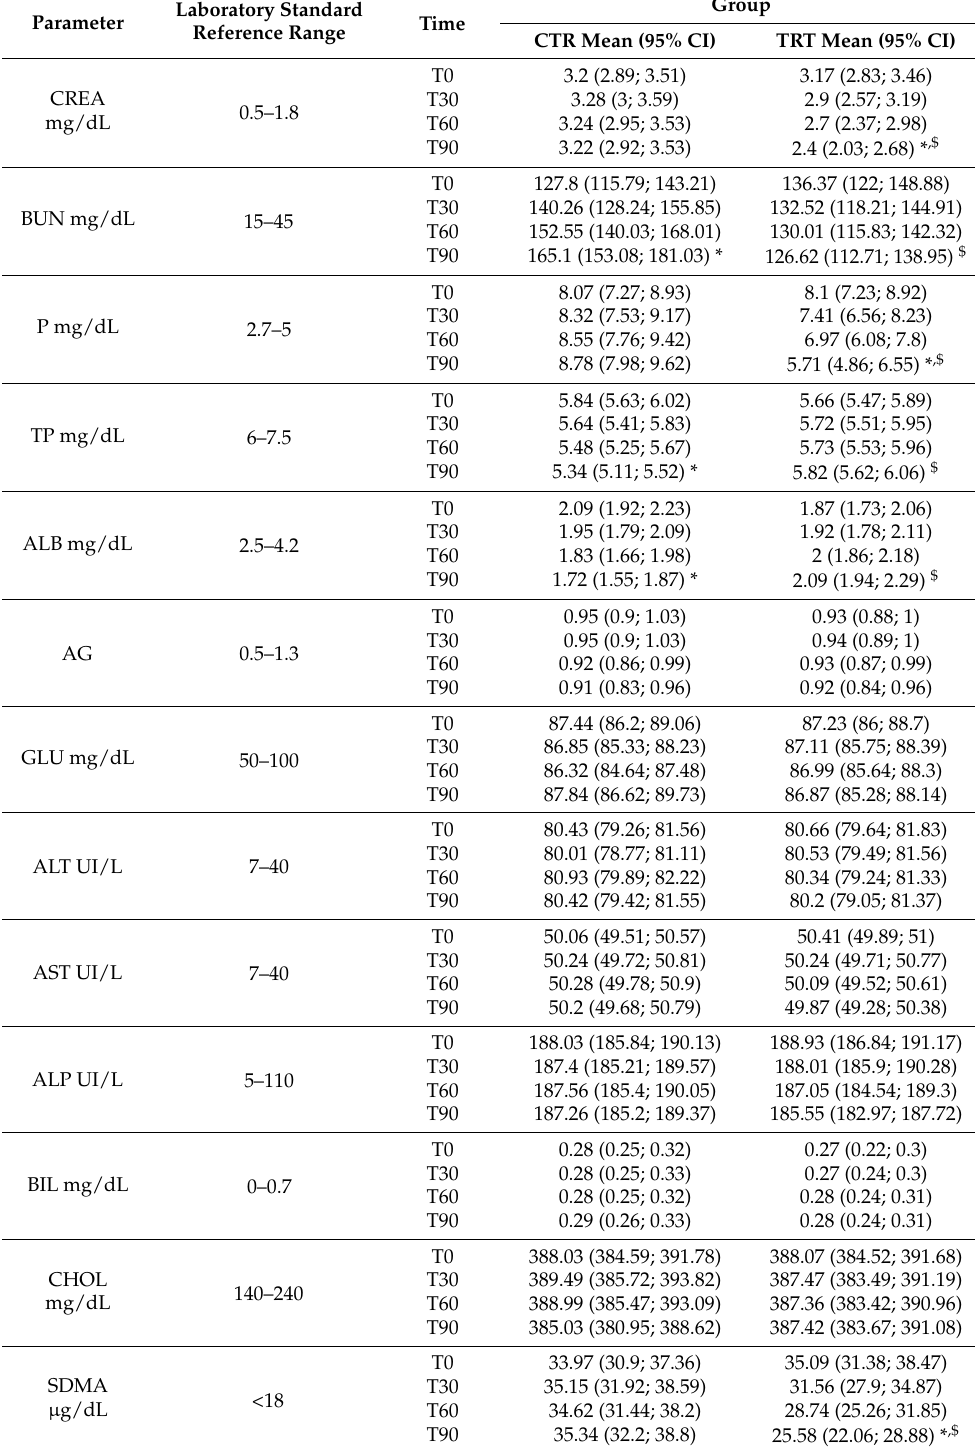
Table 4. Biochemical parameters: blood urea nitrogen (BUN), creatinine (CREA), phosphorus (P), total protein (TP), albumin (ALB), albumin/globulin (AG), glucose (GLU), alanine aminotransferase (ALT), aspartate aminotransferase (AST), alkaline phosphatase (ALP), bilirubin (BIL), cholesterol (CHOL), symmetric dimethylarginine